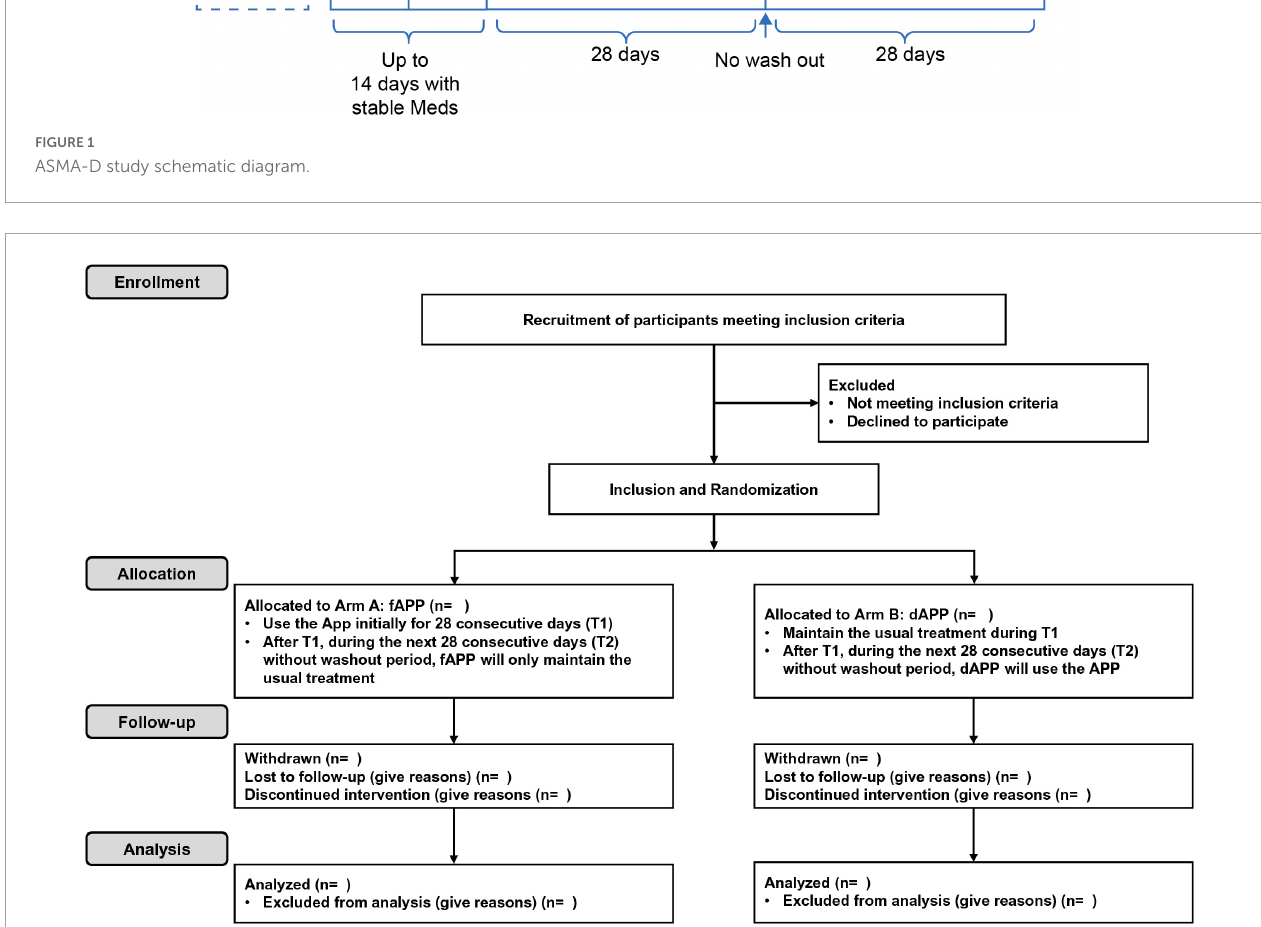
FIGURE2 SPIRIT flow diagram of the ASMA-D